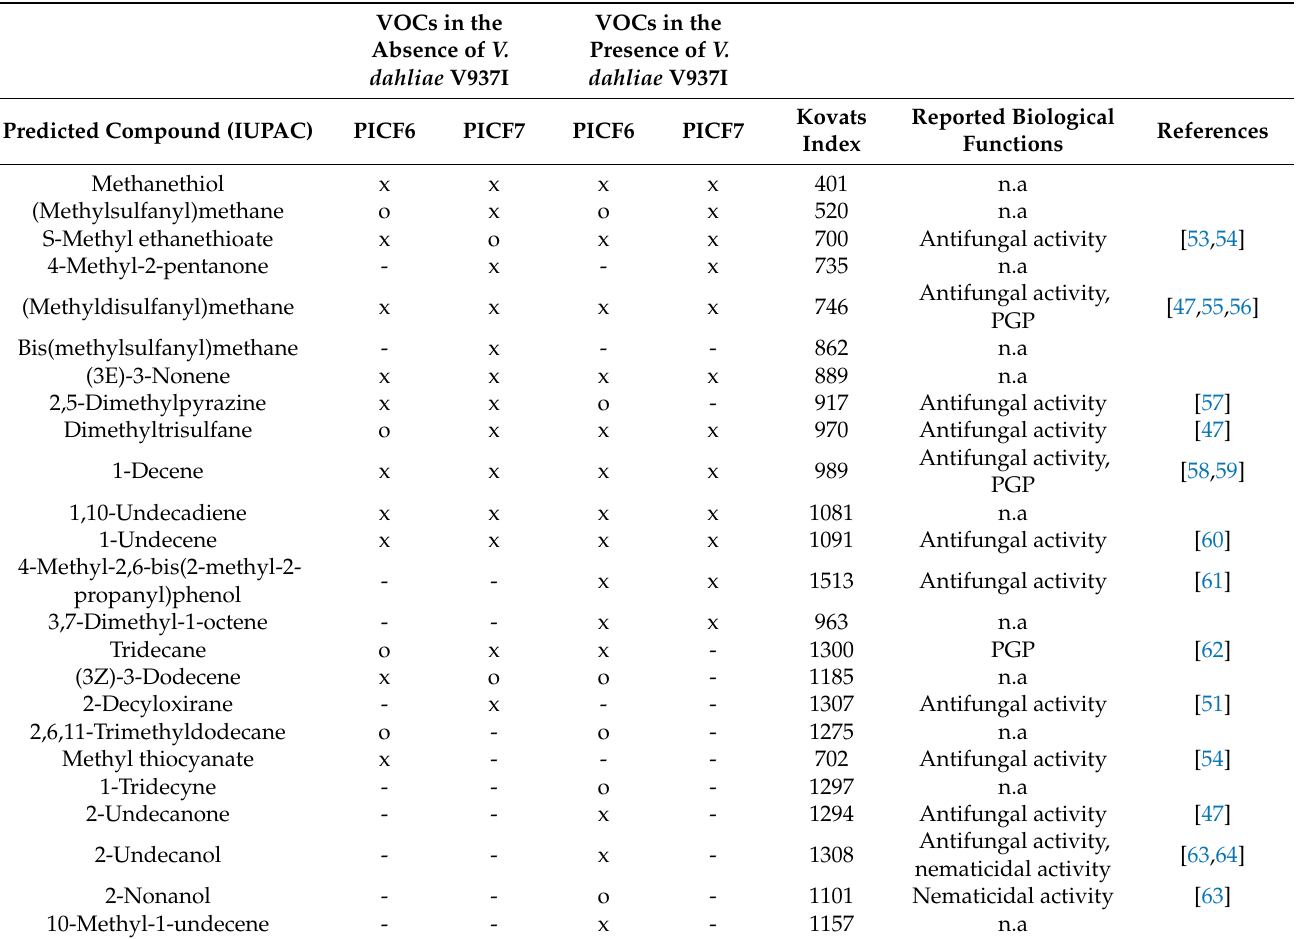
Table 2. Volatile organic compounds (VOCs) produced by the olive root endophytes Pseudomonas sp. PICF6 and Pseudomonas simiae PICF7, alone and during co-incubation with Verticillium dahliae V937I. VOCs in the VOCs in the Presence of Absence of V.